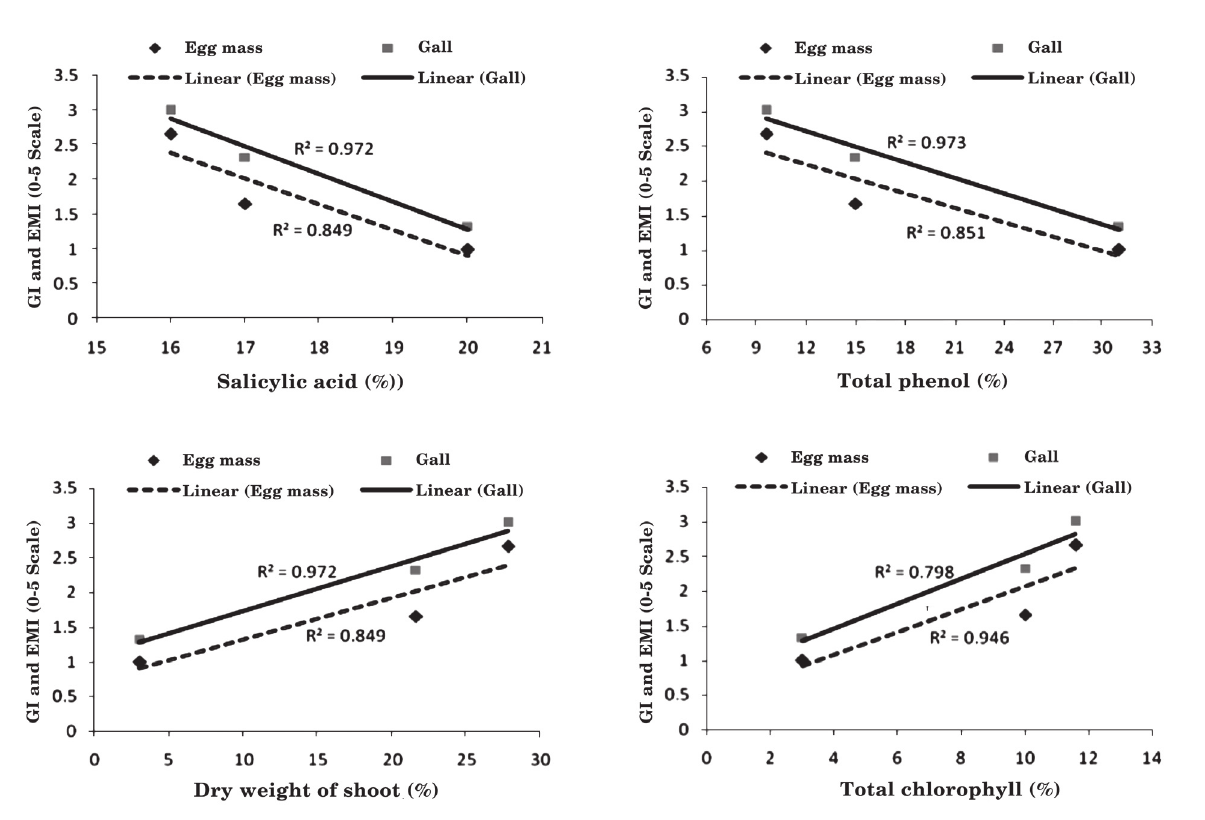
Figure 1. Correlations between gall (GI) and egg mass (EMI) indices with phenol, salicylic acid, total chlorophyll contents and dry weights of shoots of tobacco cultivars inoculated with Meloidogyne incognita (2000 J